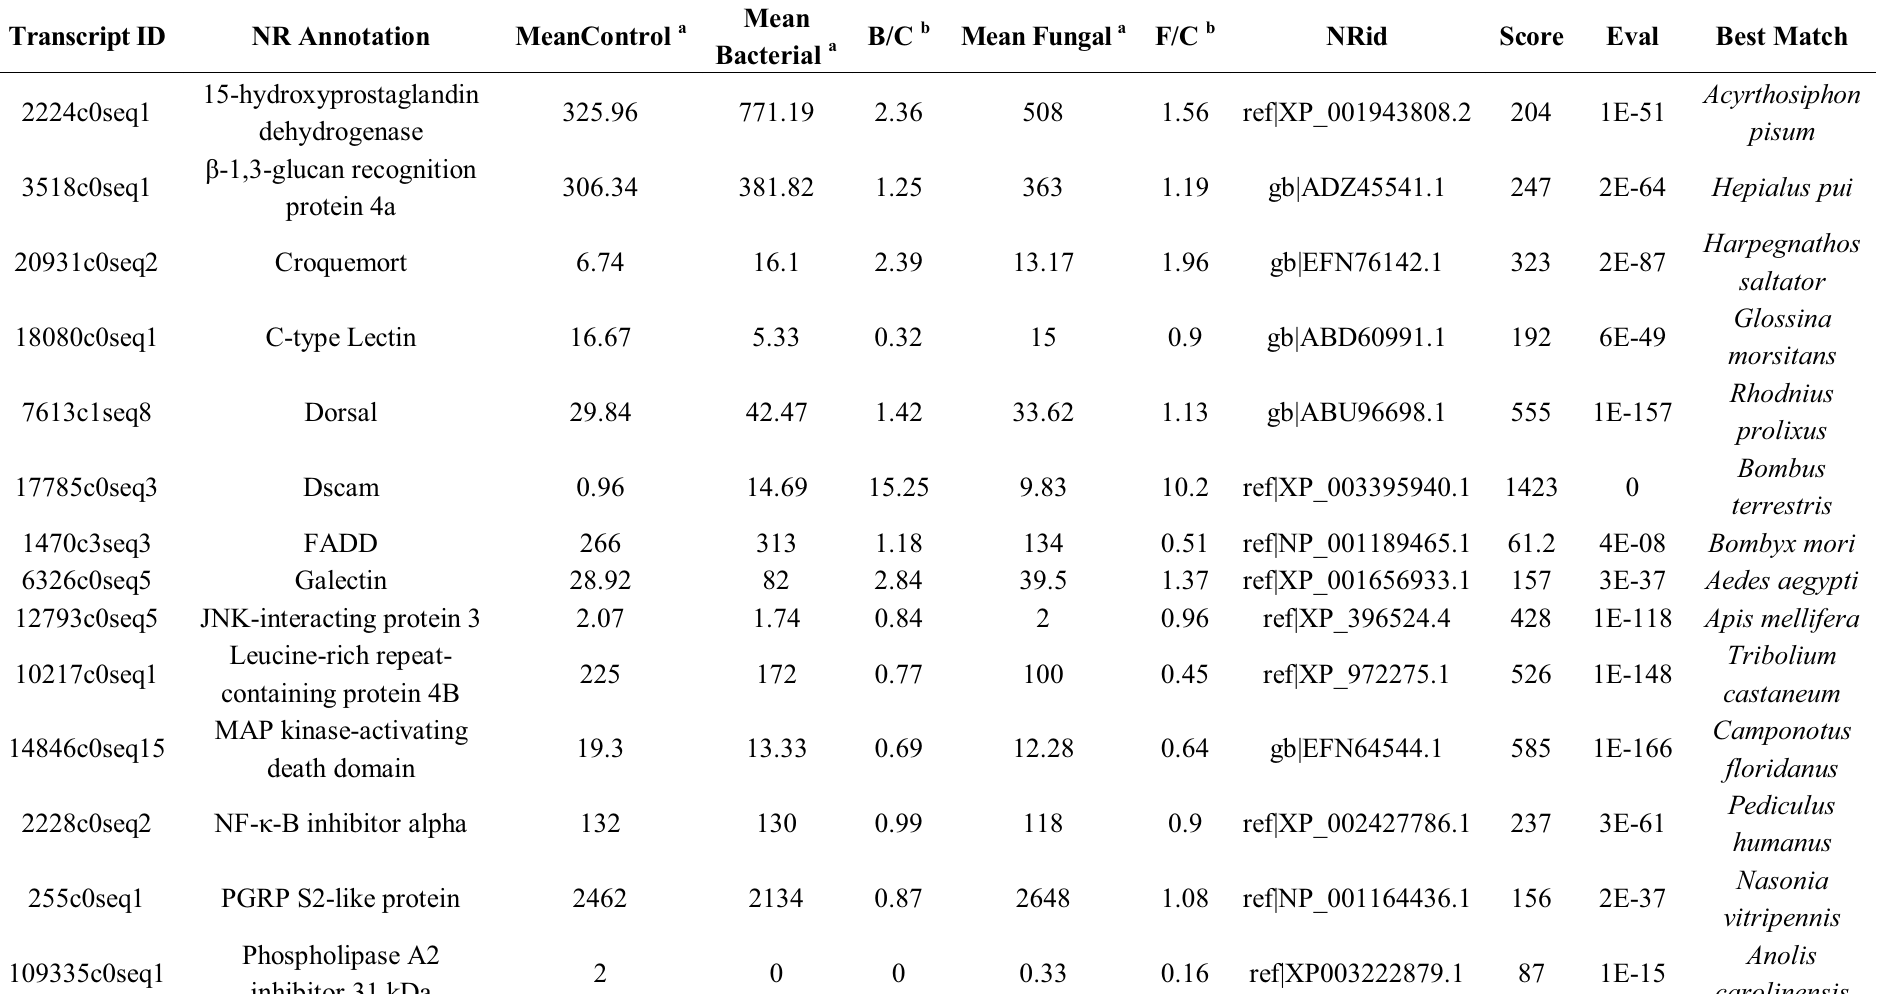
Table 2. Expression Profiling of Anasa tristis Pattern Recognition and Signal Transduction Unigenes in Response to Bacterial or Fungal Elicitation 18 h post